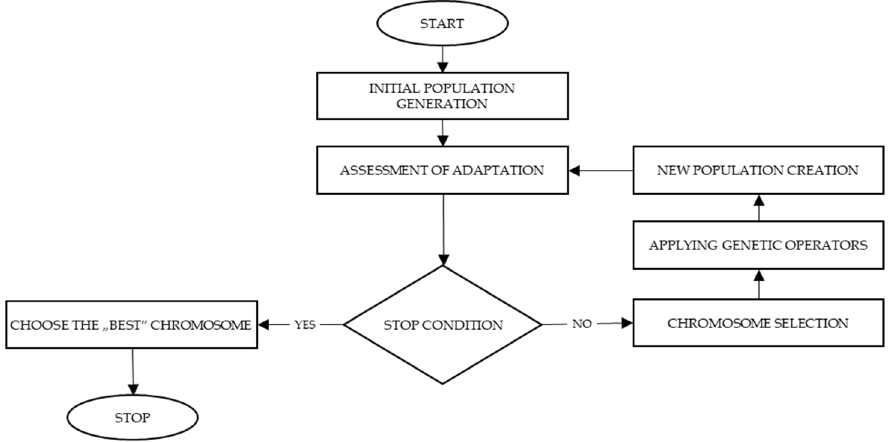
Figure 4. A scheme of genetic algorithm.